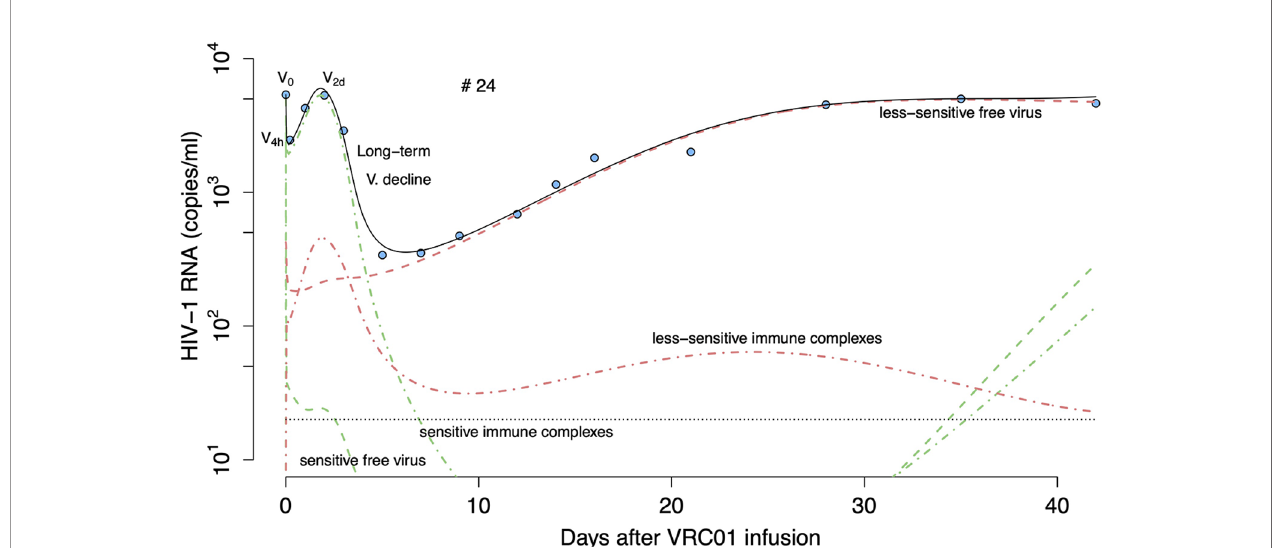
FIGURE 11 | Prediction of the two viral population phagocytosis-based logistic clearance model, equation (20), for free virus and immune complexes in participant #24. Blue- fi lled circles are the HIV-RNA and the solid black line is the model predictions ( V s + V r + C s + C r ). Green and red dashed lines show the sensitive ( V s ) and less sensitive ( V r ) free virus concentration prediction. Red and green dotted-dashed lines present the complexes formed by VRC01 and the sensitive ( C s ) or less sensitive virus ( C r ).